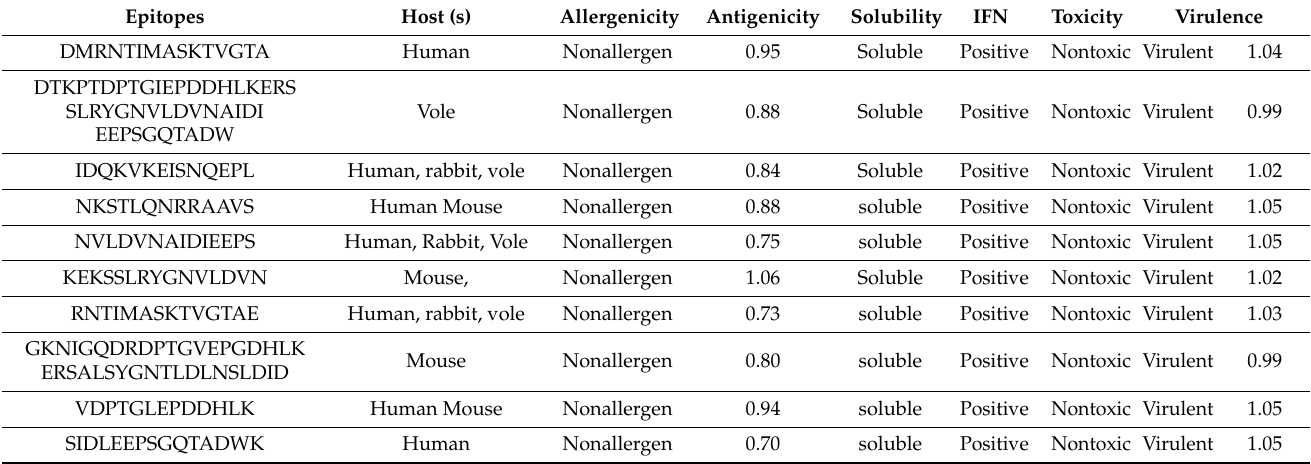
Table 1. Shortlisted epitopes for design of multi-epitopes vaccine